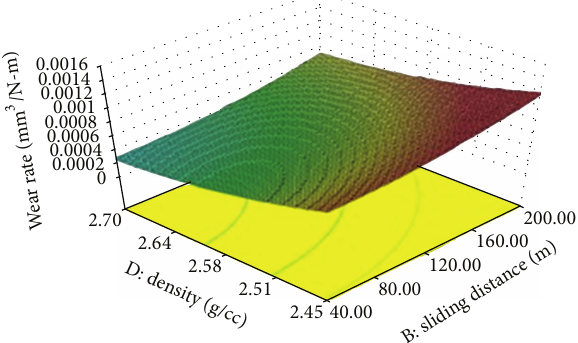
Figure 10: Variation of wear rate of Al-Gr composites with distance and density.